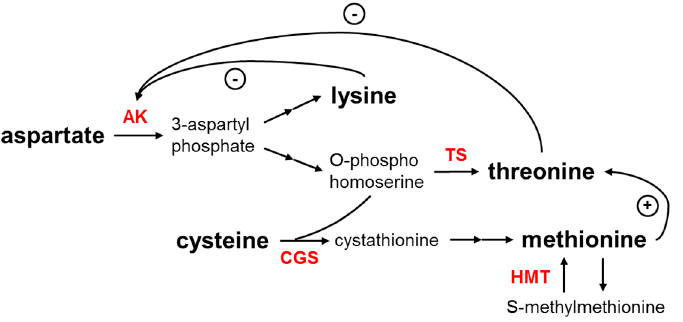
Figure 3. Schematic representation of amino acid biosynthetic pathways in plants. Curved arrows with a ( − ) sign represent major feedback inhibition loops by the end product amino acids and arrows with a (+) sign represent activation. (AK, aspartate kinase; TS, threonine synthase; CGS, cystathionine γ -synthase; HMT, homocysteine S-methyltransferase). Both lysine and methionine are synthesized from aspartate via different pathways.